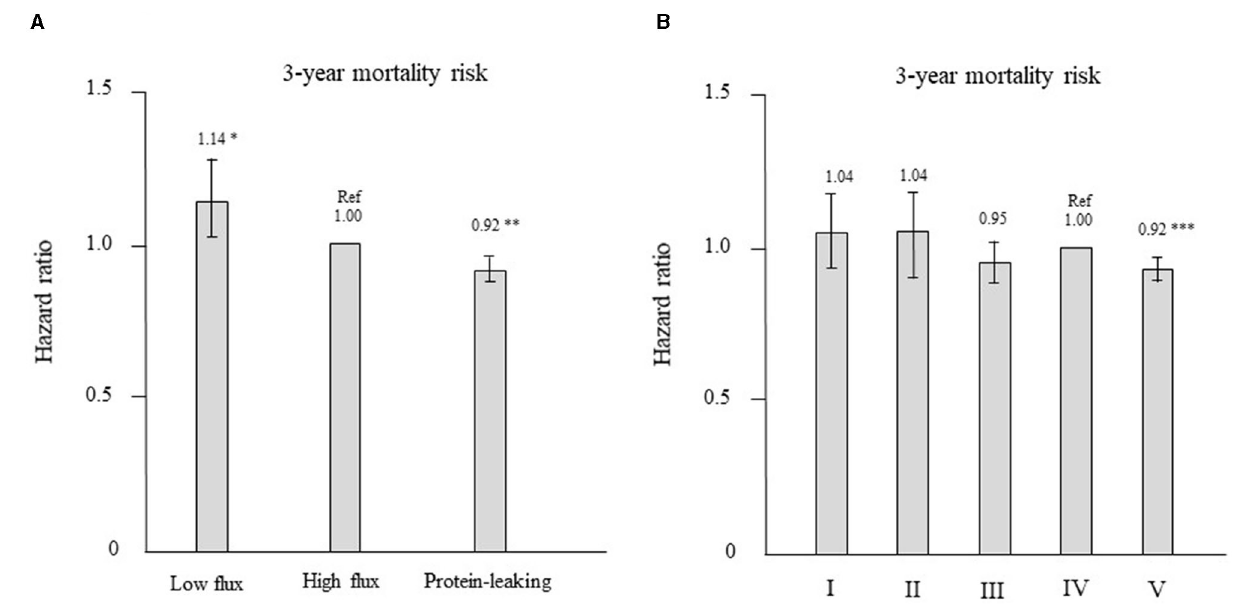
FIGURE 6 | (A) Hazard ratios for all-cause mortality after propensity score matching for the 3 types of dialyzers in the international classification (reference: high-flux dialyzer), determined using Cox proportional hazards regression. * P < 0.05, ** P < 0.01 vs. the high-flux dialyzer. Error bars correspond to 95% confidence intervals. (B) Hazard ratios of all-cause mortality after propensity score matching for the 5 types of dialyzers in the Japanese classification (reference: type IV dialyzer), determined using Cox proportional hazards regression. *** P < 0.001 vs. the type IV dialyzer. Error bars correspond to 95% confidence intervals.